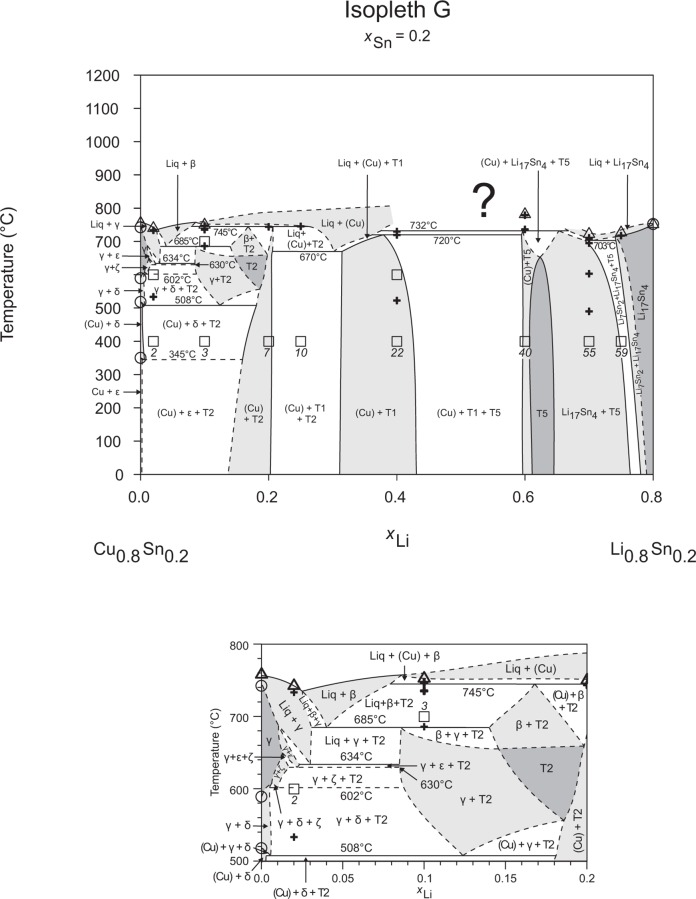
Isopleth G including section from xLi = 0–0.20 / T = 500–800°C.